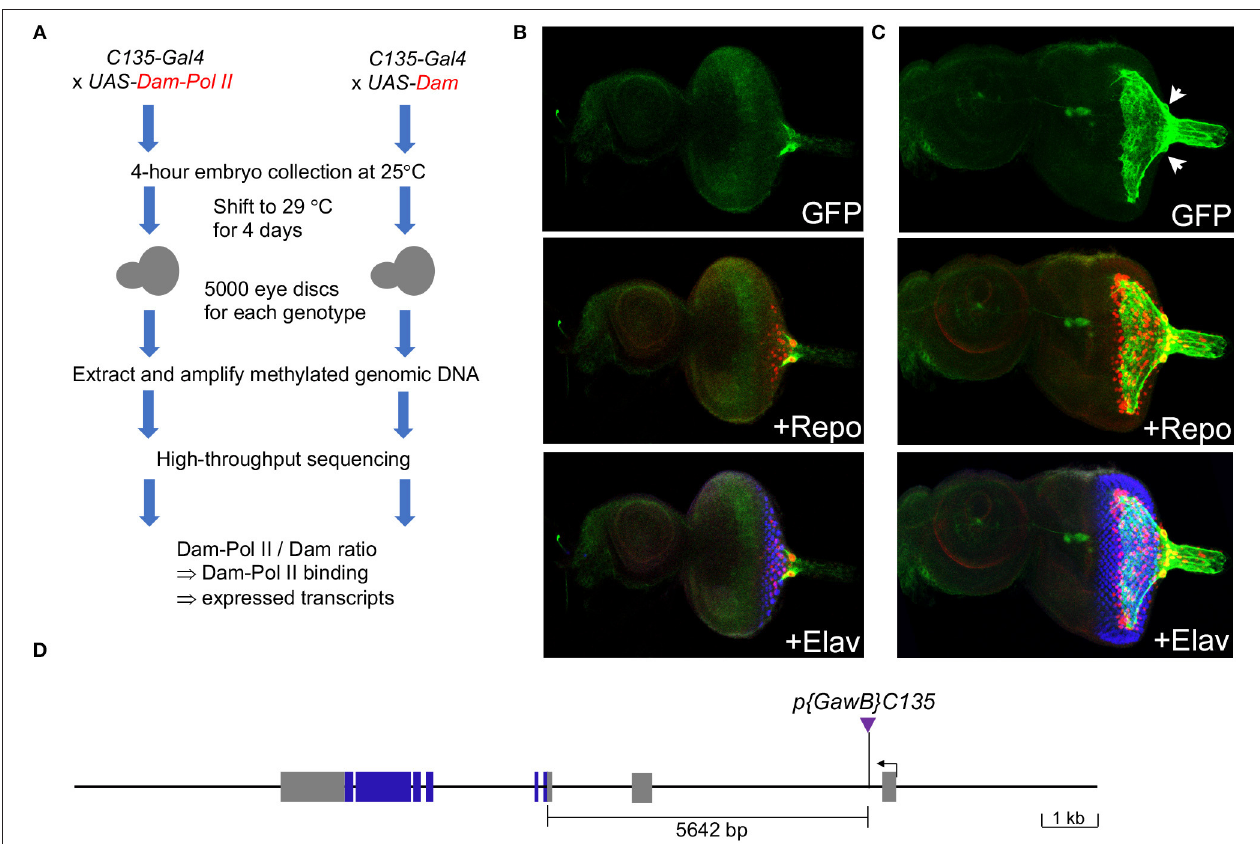
FIGURE 1 | Characterization of the C135-Gal4 driver used in this study. (A) Experimental design: the C135-Gal4 driver was used to drive the expression of Dam-Pol II and Dam. There was no temporal control of Gal4 expression as C135-Gal4 drives no expression in the embryonic eye field. (B,C) Expression of the C135-Gal4 driver in the eye discs of early-third (B) and mid-third (C) instar larvae. All images are z-projection of confocal sections. Larval eye imaginal disc stained for the presence of carpet glia membrane (GFP staining, green), glial nuclei (Repo staining, red), and differentiated PRs (Elav staining, blue). (D) Insertion of C135-Gal4 in the path locus. The organization of the path locus is depicted. C135-Gal4 , indicated by a purple triangle, is inserted 5642 bp upstream of the translational start